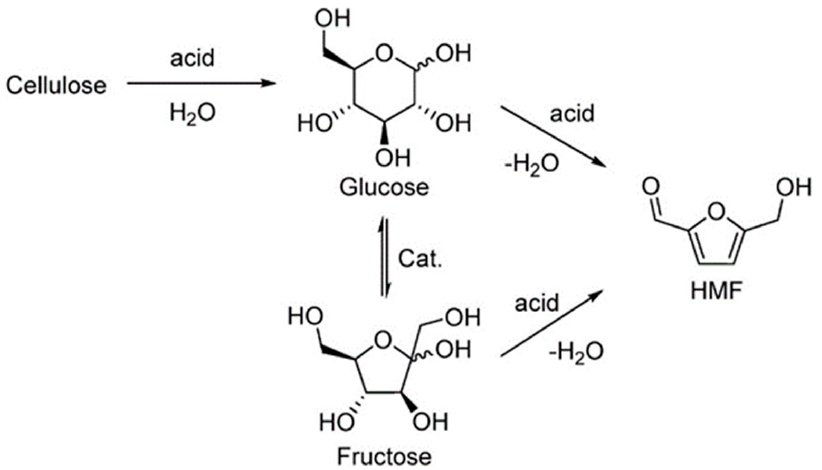
Figure 6. Cellulose conversion into 5-hydroxymethylfurfural. Adapted with permission from ref. [102] © 2018 Elsevier B.V. All rights reserved.